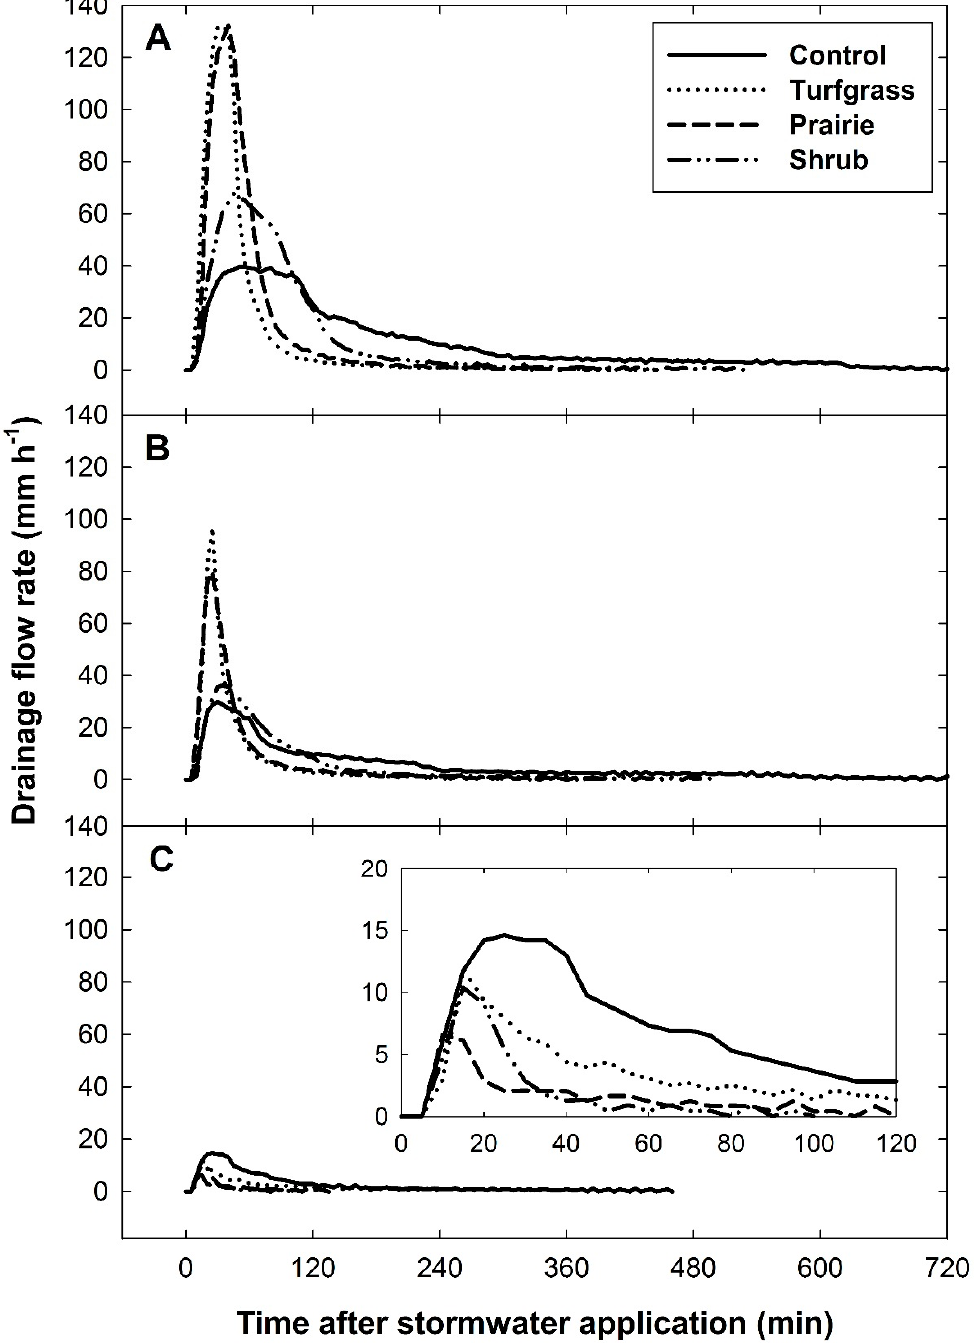
Figure 4. Exemplary drainage response curves (mm h − 1 ) on dates following a large input event ( A , 127.3 mm on 16 June), a medium input event ( B , 63.7 mm on 9 June), and a small input event ( C , 31.8 mm on 3 June). Plotted values are raw treatment means ( n = 3 per treatment) recorded over five-minute intervals, the resolution of drainage collection in this study, for the duration of drainage flow above a measurement threshold of 0.25 mm h − 1 .